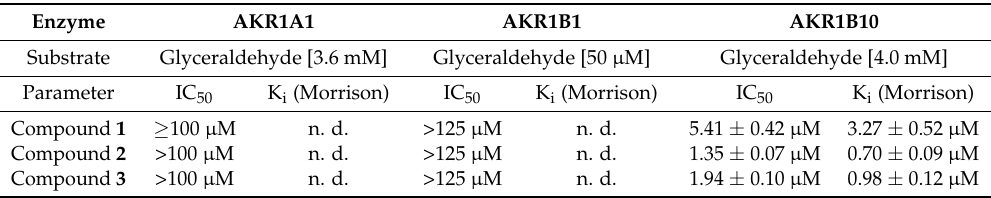
Table 2. IC 50 and K i values of the isolated hop-compounds for the respective reductases. IC 50 and K i values are presented as mean ± SD of at least three experiments. (n. d. = not determined). Enzyme AKR1A1 AKR1B1 AKR1B10